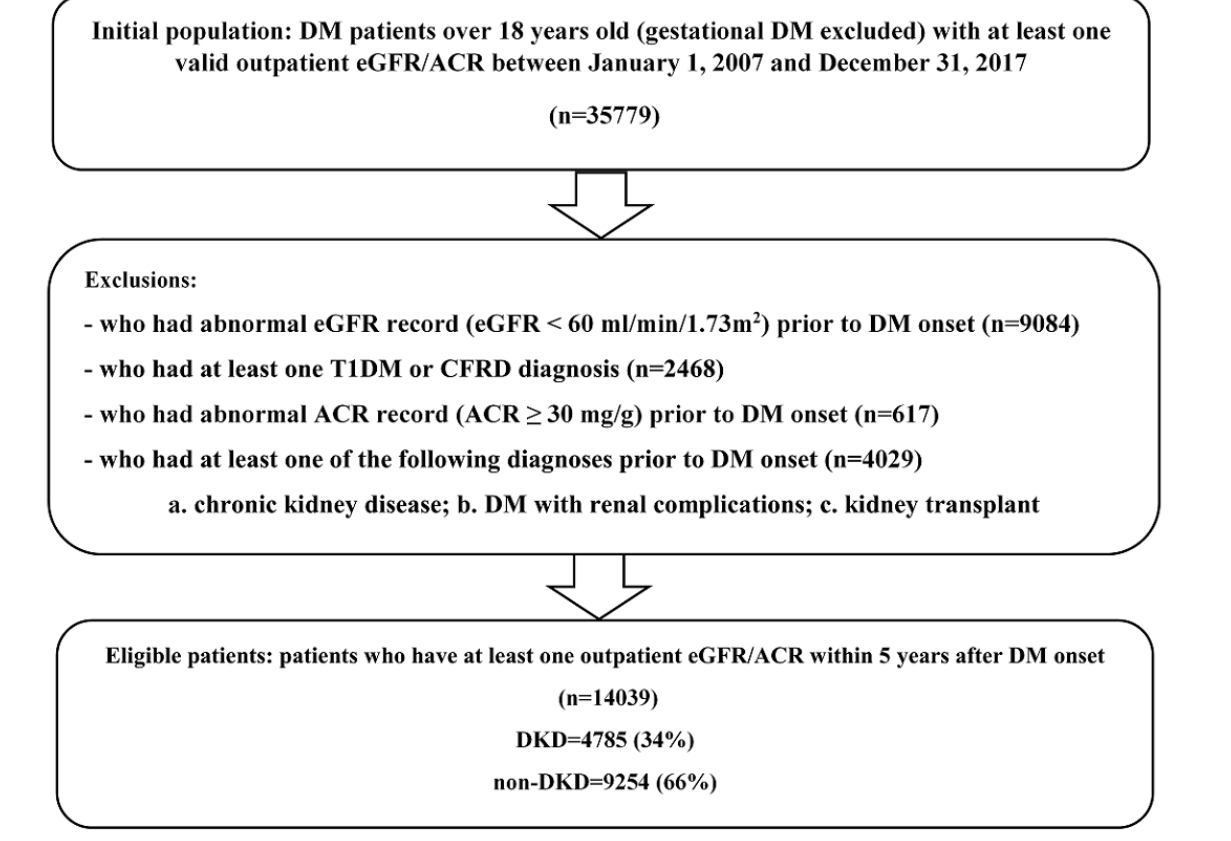
Figure 1. Study cohort inclusion and exclusion. Note that the counts of exclusions do not necessarily add up to the difference between the initial and final population, as 1 patient could satisfy multiple exclusion criteria. ACR: albumin-to-creatinine ratio; DKD: diabetic kidney disease; DM: diabetes mellitus; EGFR: estimated glomerular filtration